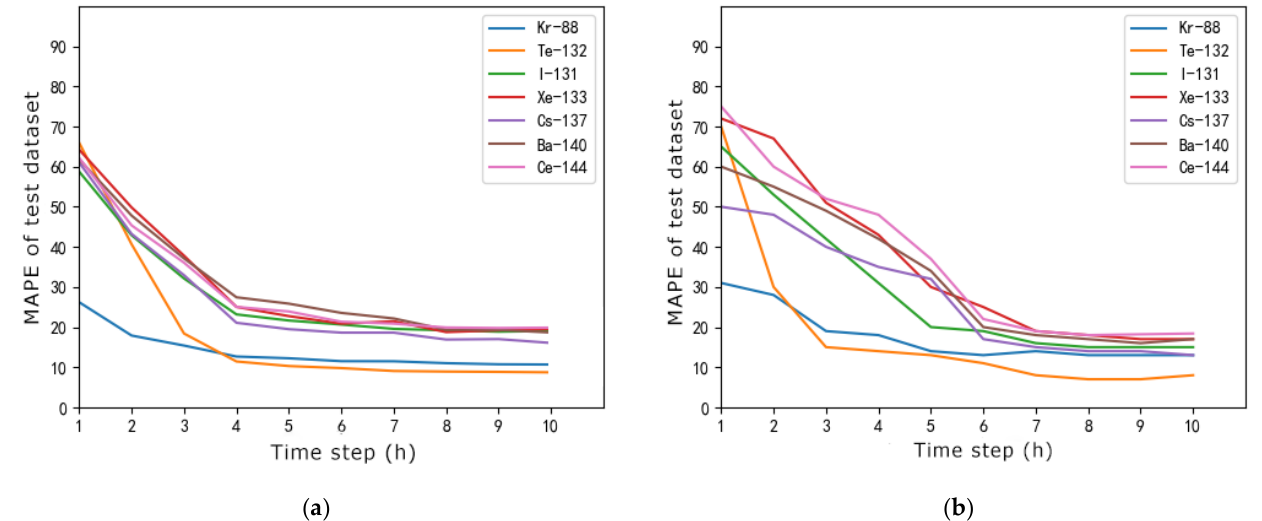
Figure 9. Prediction results of models with time step. ( a ) TCN model; ( b ) 2D-CNN model.